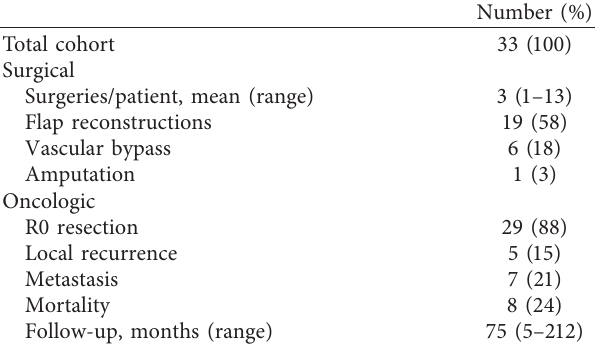
Table 3: Surgical and oncologic